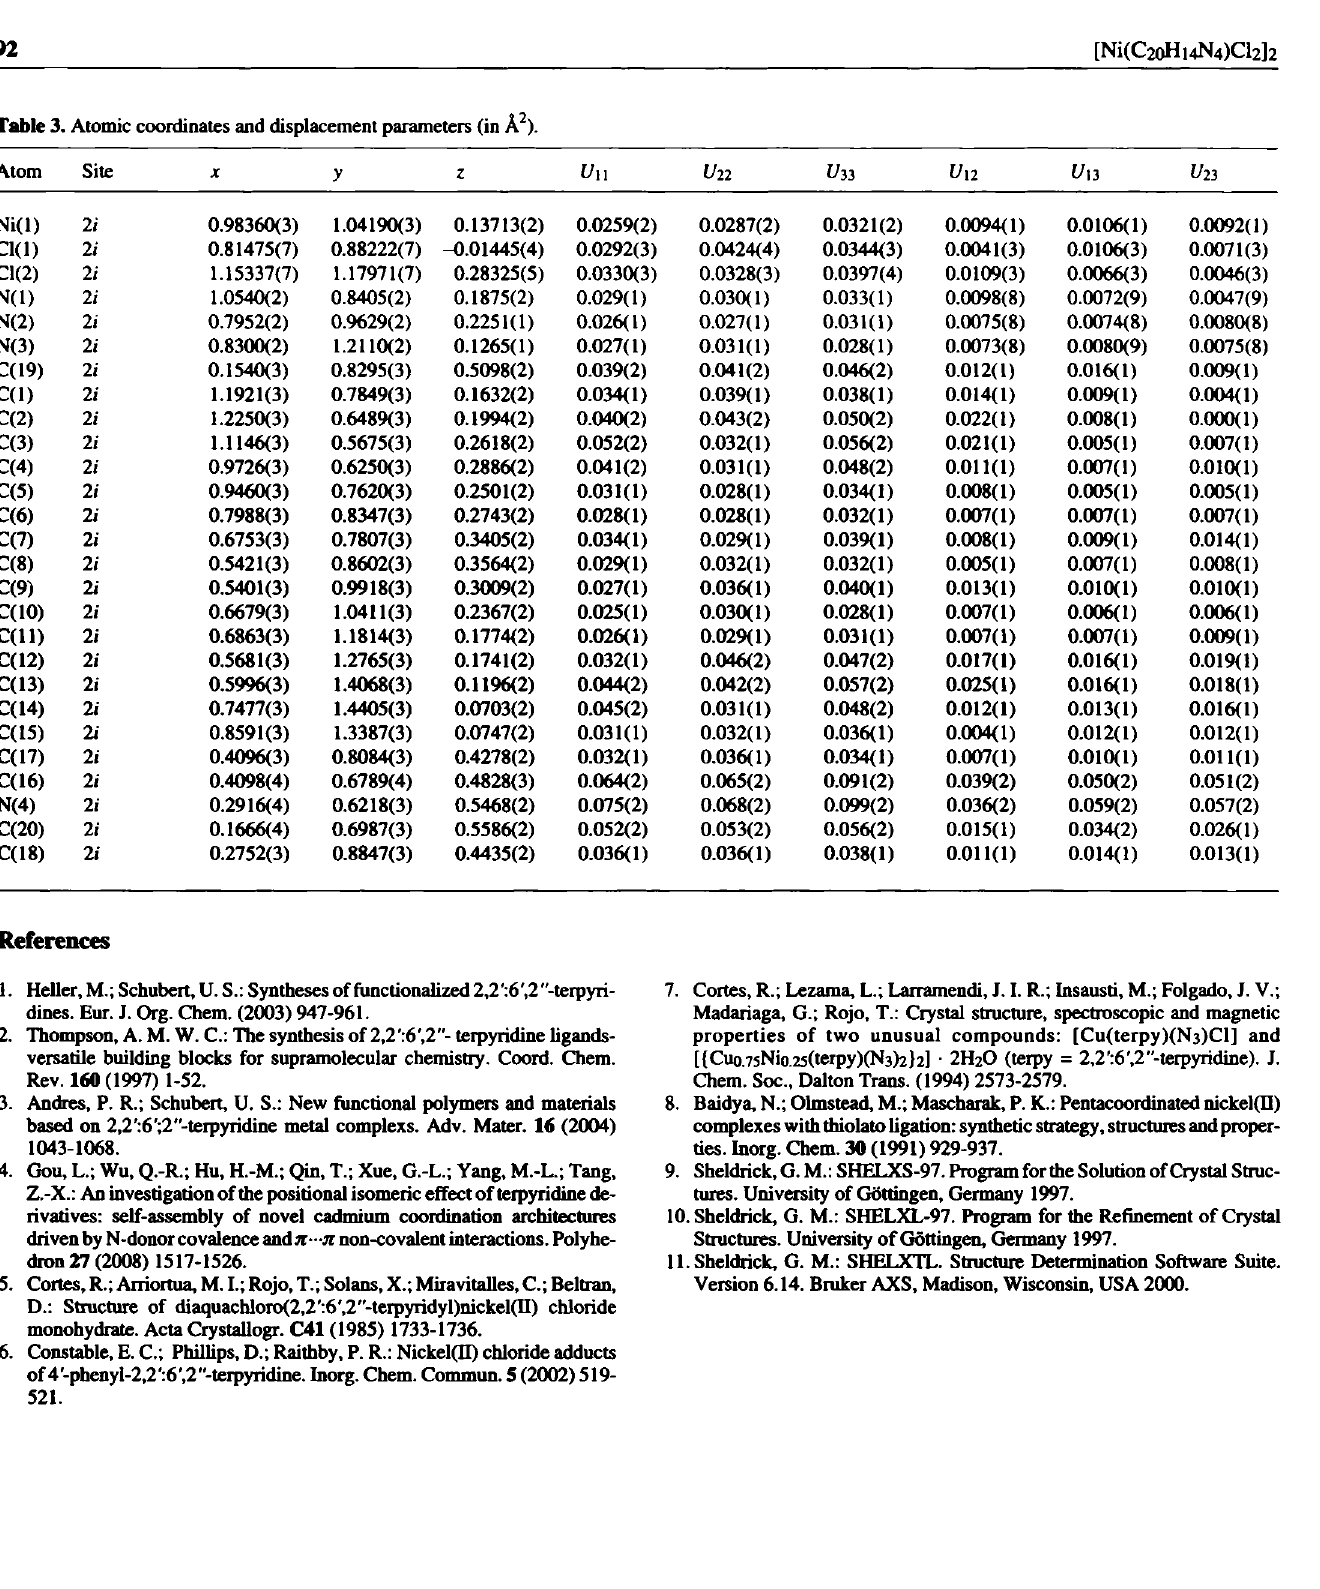
Table 3. Atomic coordinates and displacement parameters (in Â 2